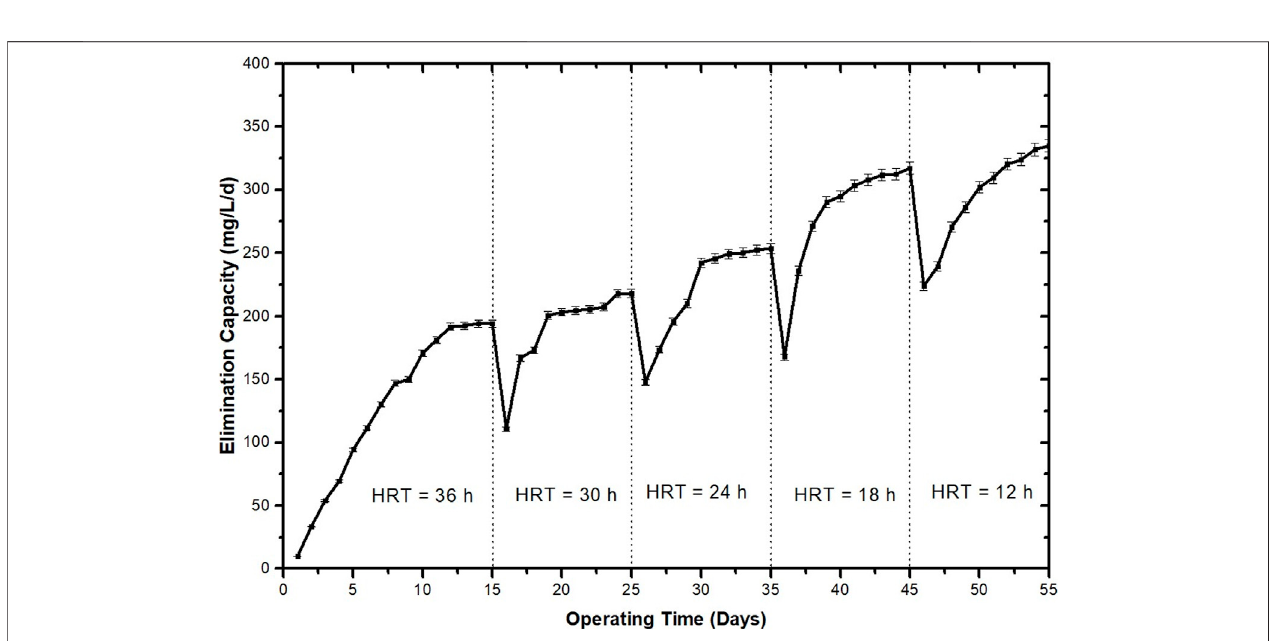
FIGURE 3 | Effect of HRT on butachlor elimination capacity of the